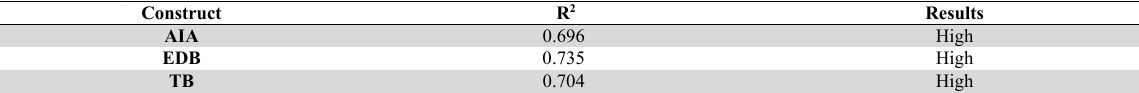
R 2 of the endogenous latent variables